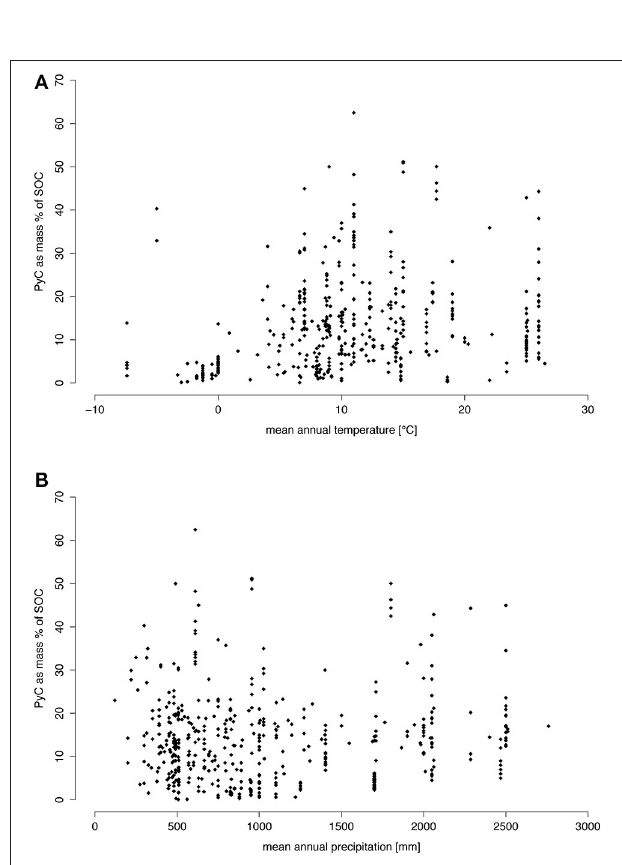
FIGURE 6 | PyC content as mass % of the total SOC plotted against climatic variables: mean annual precipitation (A) and mean annual temperature (B). Spearman’s rank correlation yielded a p -value of 0.66 and a rho of − 0.02 for the precipitation and a p < 0.001 with a rho of 0.33 for the